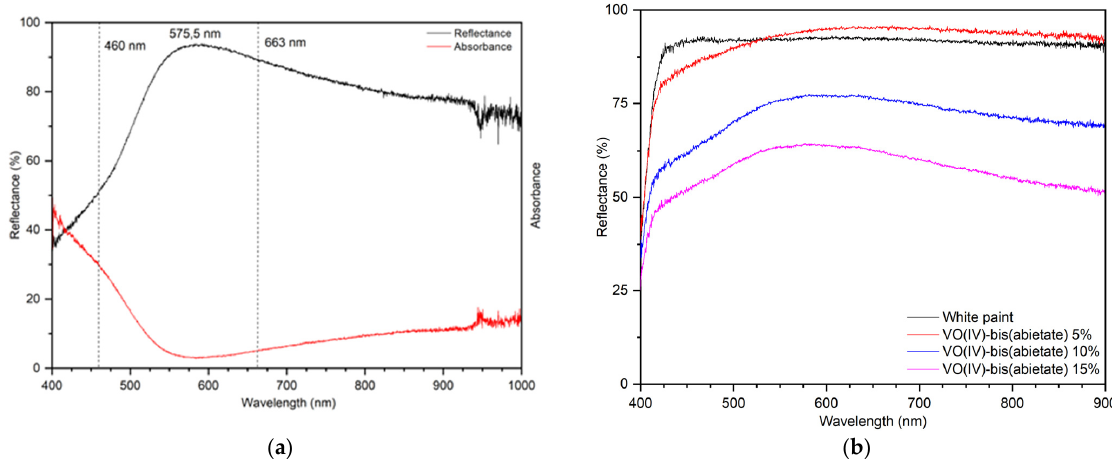
Figure 6. ( a ) Vis-NIR spectrum of VO(IV)- bis (abietate) complex in powder form. ( b ) Vis-NIR spectrum of VO(IV)- bis (abietate) complex dispersed in the paint at different concentrations.